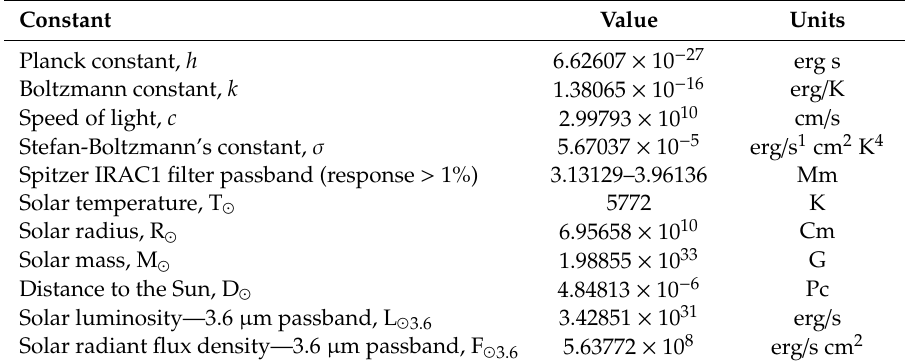
Table A3. Values adopted for estimation of Spitzer 3.6 µ m MLR coe ffi